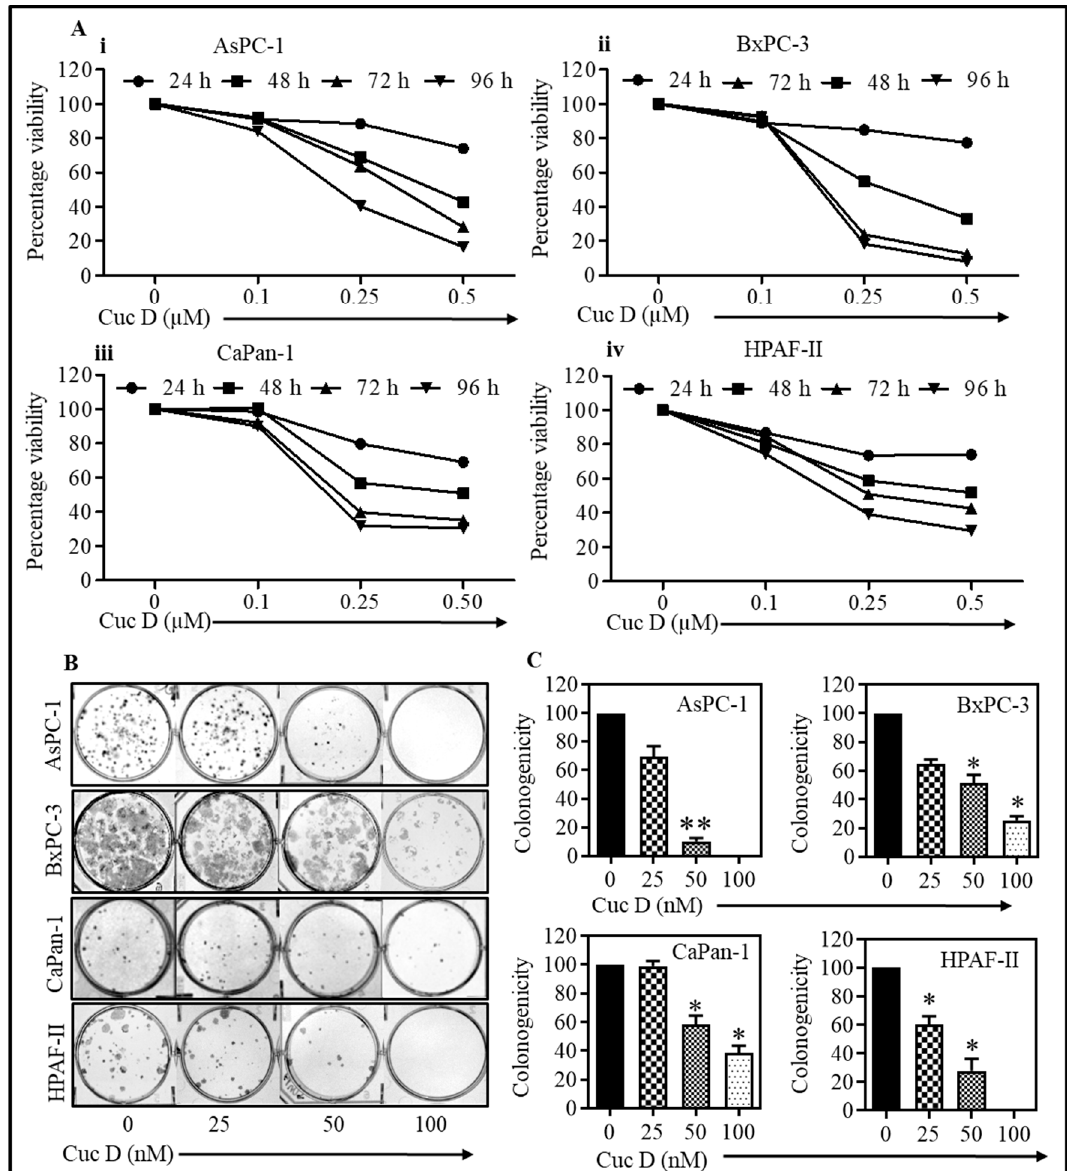
Figure 1. Cuc D decreases proliferation and colony formation of pancreatic cancer cells. ( A ) Cuc D decreases the proliferation of AsPC-1, BxPC-3, CaPan-1, and HPAF-II cells ( Ai – Aiv ). Briefly, PanCa (2500) cells were seeded in each well of 96-well plate and after overnight incubation; cells were treated with indicated concentrations of Cuc D for 24, 48, 72, and 96 h. Cell viability was assessed by MTS assay. The graph represents the percent viable cells compared to the vehicle-treated cells. Each concentration value shown in bar graph is the mean ± SE of quadruplicates wells of each group. ( B ) Cuc D inhibits colony formation ability of PanCa cells ( B , C ). In brief, 500 cells were seeded in each well of 6-well plates. After three days, the cells were treated with indicated concentrations of Cuc D and colonies obtained were stained with hematoxylin. Photographs were taken by UVP-gel documentation system for all cells. Bar graphs represent number of percentage of colonies formed with respect to vehicle control in each group. The experiments were performed in triplicate. Asterisk (*) denotes the significant value p < 0.05 when applied student’s t -test, and two asterisks (**) indicates as significance of p <